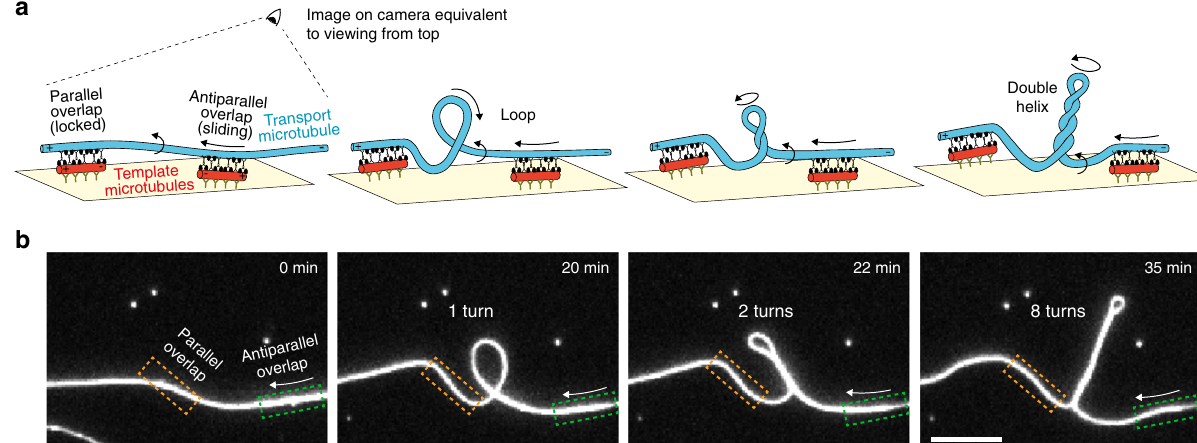
Fig. 5 Twisting and coiling of Ncd-driven, sliding transport microtubules. a Schematics of a 2D sliding motility assay on an unstructured glass surface where the leading end of a long transport microtubule (Atto647n-labeled, blue) is locked in a parallel con fi guration on one template microtubule (rhodamine-labeled, red) while the trailing end of the same transport microtubule is sliding in an antiparallel con fi guration on another template microtubule. The rotational motion of the transport microtubule twists the central part of the transport microtubule and further causes the transport microtubule to bend into a loop, before coiling up into a double helix. b Time-lapse micrographs of the transport microtubule from an event as illustrated in ( a ). The positions of parallel and antiparallel microtubule overlaps (obtained from dual-color micrographs, see Supplementary Movie 4) are indicated by the orange and green boxes, respectively. Scale bar: 10 μ m. Three more example events are shown in Supplementary Fig.